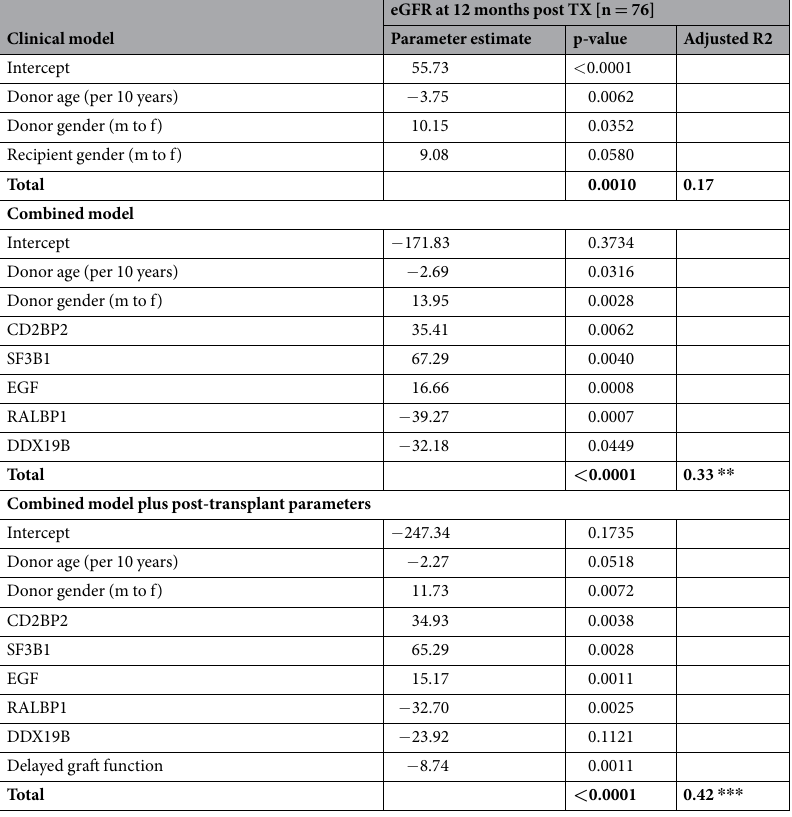
Table 3. Multiple linear regression analysis predicting 12 months post-TX eGFR values. Parameter estimates, p-values and adjusted R 2 values for the three regression models are given. Log2 marker expression values were used in the modeling analysis. The combined model was significantly better (p-value = 0.0007) than the clinical model based on ANOVA, indicated by ** . Delayed graft function information significantly improved model performance (p-value < 0.0001), indicated by ***